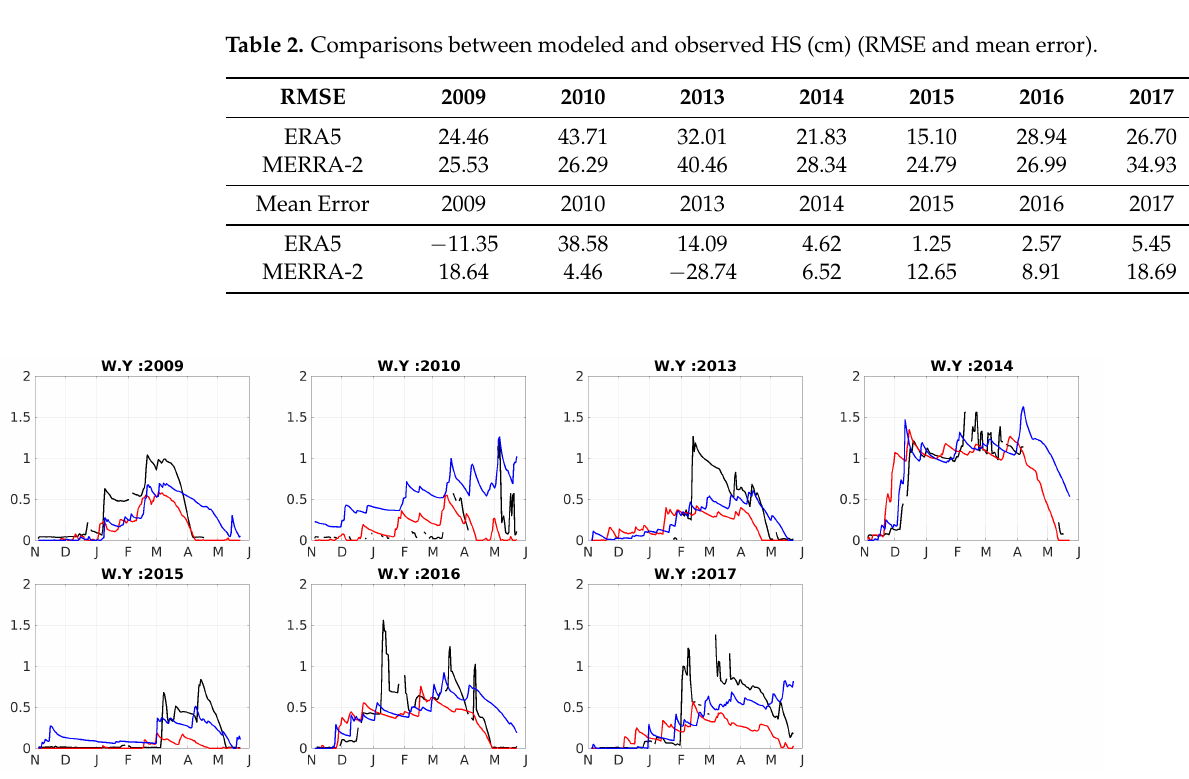
Figure 3. Comparison the daily HS at Oukaimeden (3200 m.a.s.l): black: observed HS, blue: modeled HS with ERA5 and red: modeled HS with MERRA-2.